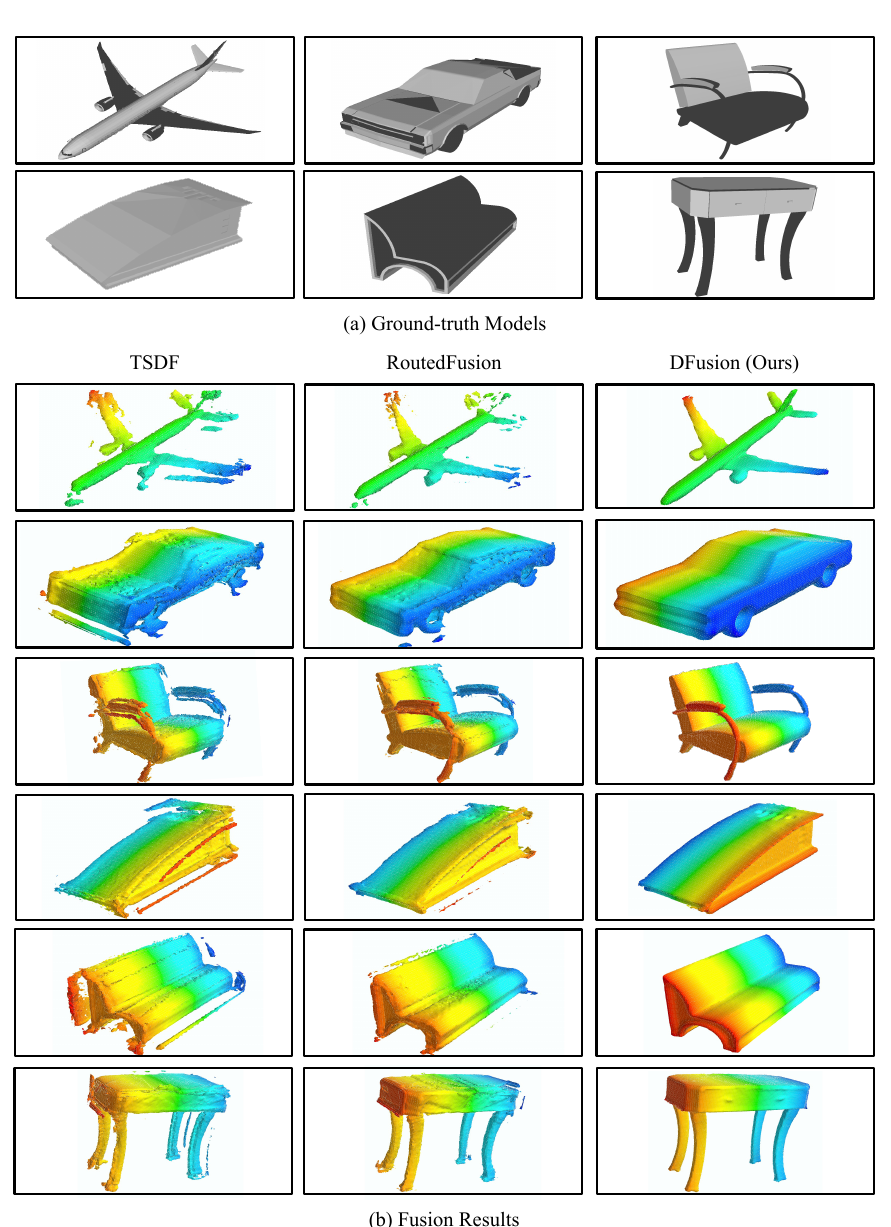
Figure 6. Fusion results on the ShapeNet dataset with pose noise